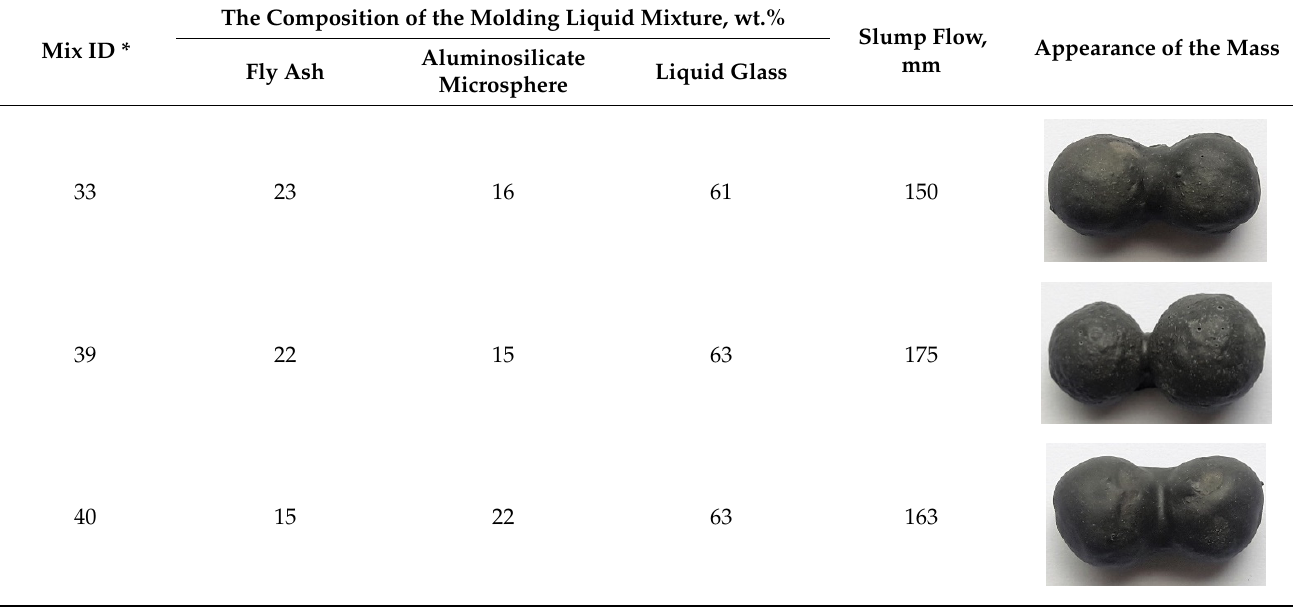
Figure 10. X-ray diffraction pattern of the liquid glass binder, fired at temperature of 350 °C: K— β - quartz; С — α -cristobalite; B—wollastonite.